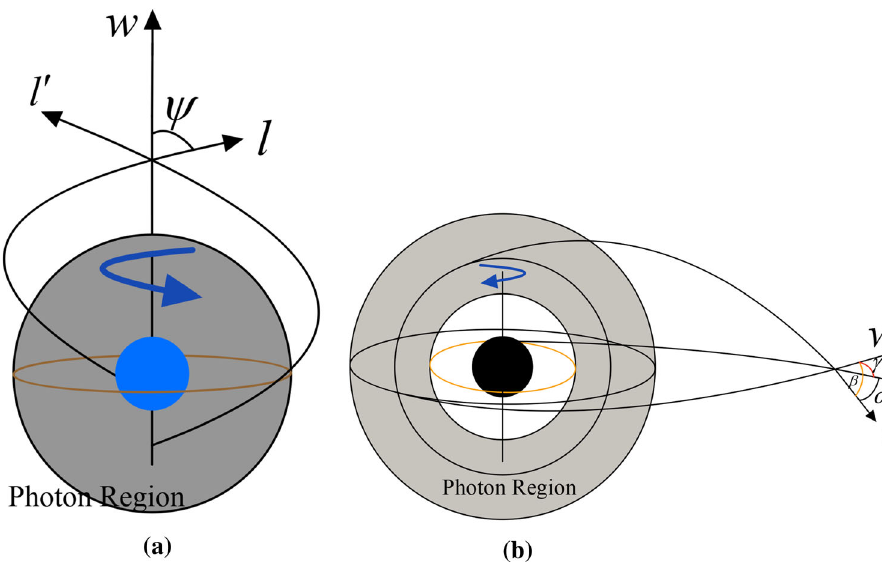
Fig. 2 Sketch of measuring the shadow of a spherically symmetric black hole. a The observers are located at θ = 0, and w is a null geodesic. The angle ψ is the angular radius of shadow. b The observers are located at θ = π/ 2. k , w , and l are light rays from photon region. α , β and γ are angles between k and l , l and w , k and l